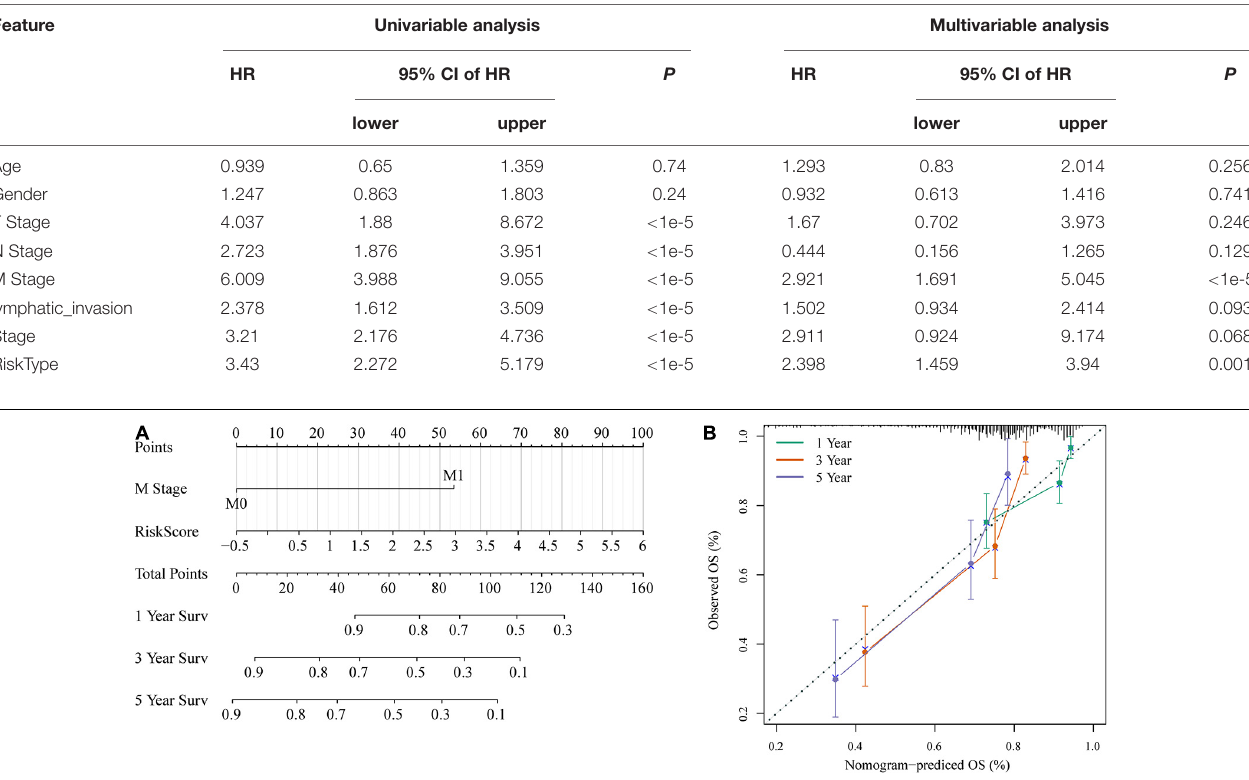
TABLE 3 | Univariate and multivariate analyses of entire TCGA dataset. Feature